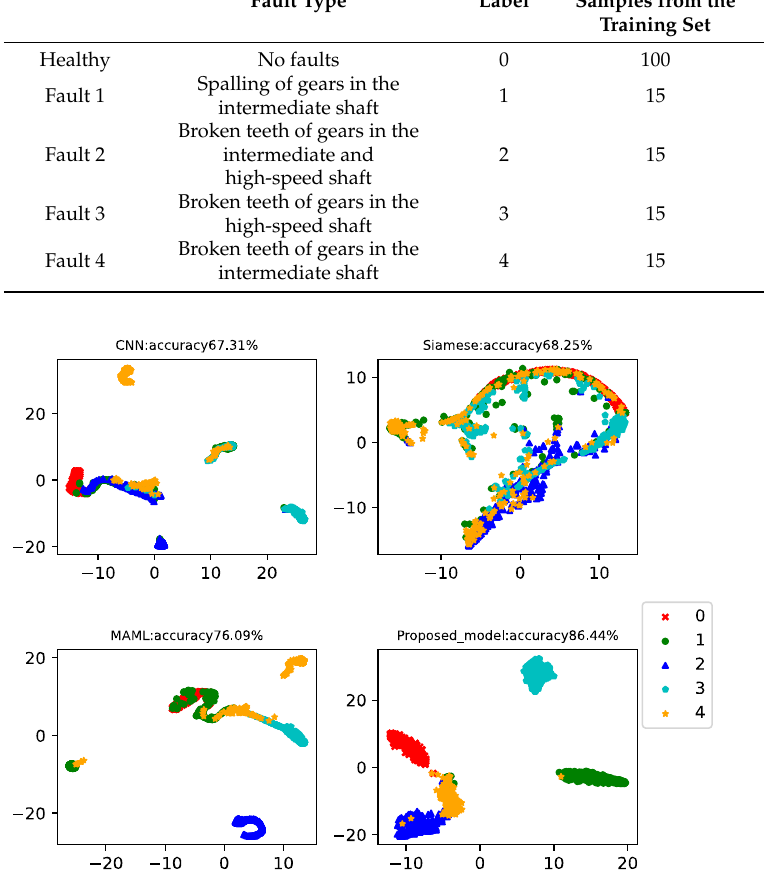
Figure 11. Five-way-one-shot diagnosis of the wind turbine gearboxes using different algorithms.